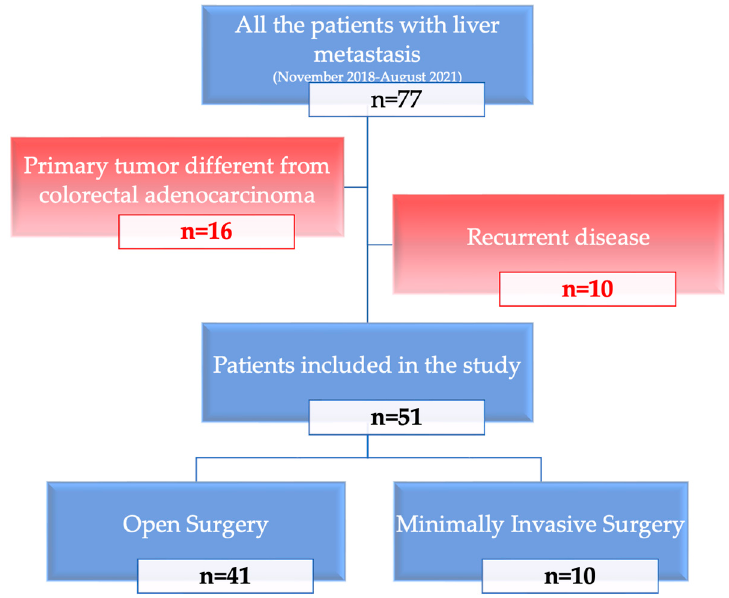
Figure 1. Flowchart representing the process of patient selection. In red: exclusion criteria.